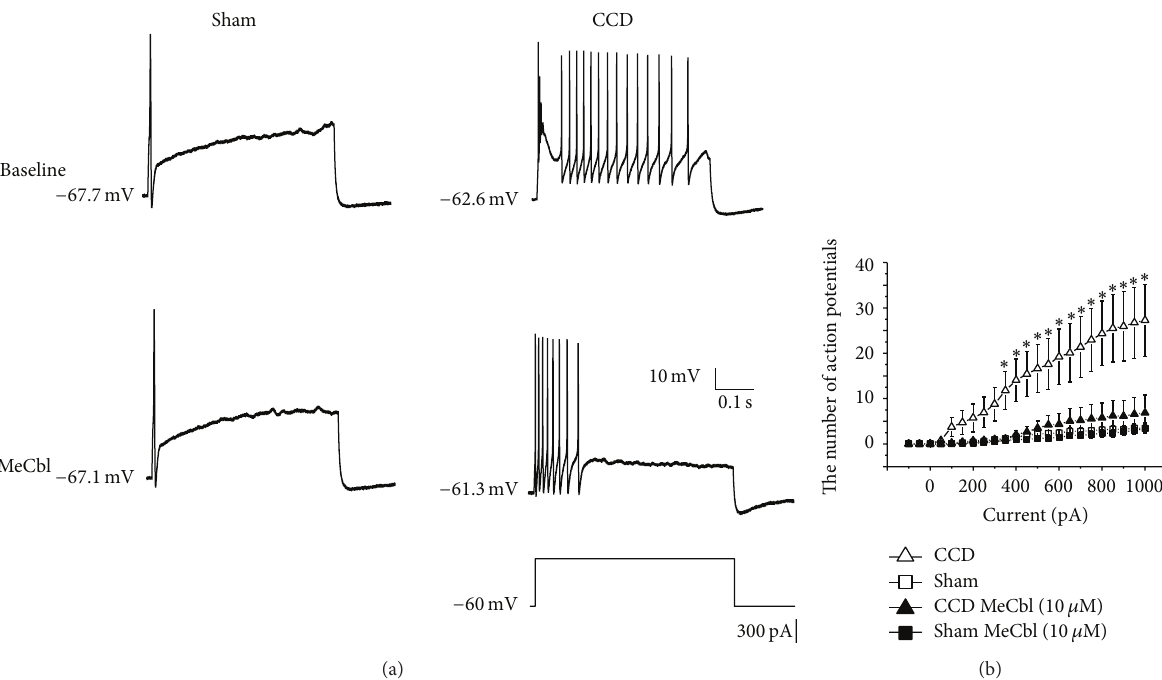
Figure 5: MeCbl inhibited the number of APs of medium-sized DRG neurons. (a) Original traces of APs induced by the depolarized square wave in absence and the presence of MeCbl. (b) Inhibitory effect of MeCbl on the number of action potentials of medium-sized DRG neurons. ∗ 𝑃 < 0.05 , compared to those in the absence of MeCbl